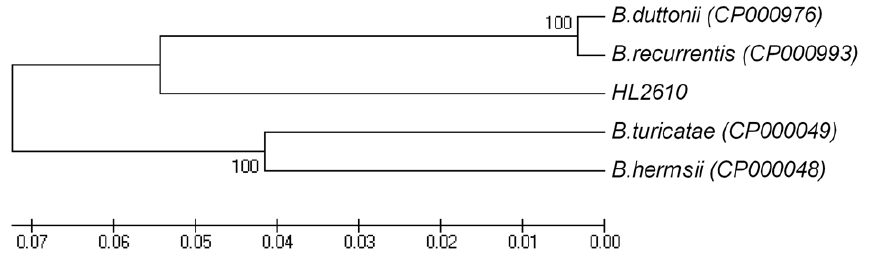
Figure 2. Phylogenetic tree based on the rrs-rrl A spacer region. The tree was inferred using the UPGMA method. The bootstrap consensus tree inferred from 250 replicates is taken to represent the evolutionary history of the taxa analyzed. Branches corresponding to partitions reproduced in less than 50% bootstrap replicates are collapsed. The percentage of replicate trees in which the associated taxa clustered together in the bootstrap test (250 replicates) is shown next to the branches. The tree is drawn to scale, with branch lengths in the same units as those of the evolutionary distances used to infer the phylogenic tree. The evolutionary distances were computed using the Maximum Composite Likelihood method and are in the units of the number of base substitutions per site. All positions containing gaps and missing data were eliminated from the dataset (Complete deletion option). There were a total of 7106 positions in the final dataset. Phylogenetic analyses were conducted in MEGA4 (9).